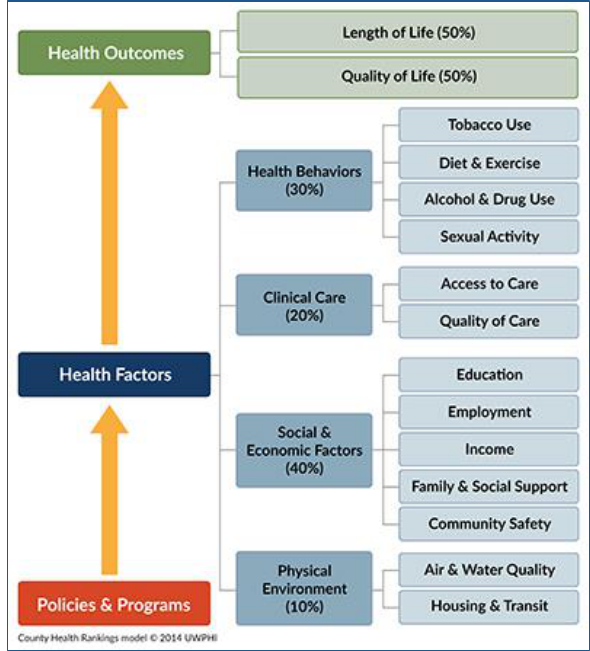
Source: County Health Rankings model © 2014, University of Wisconsin Population Health